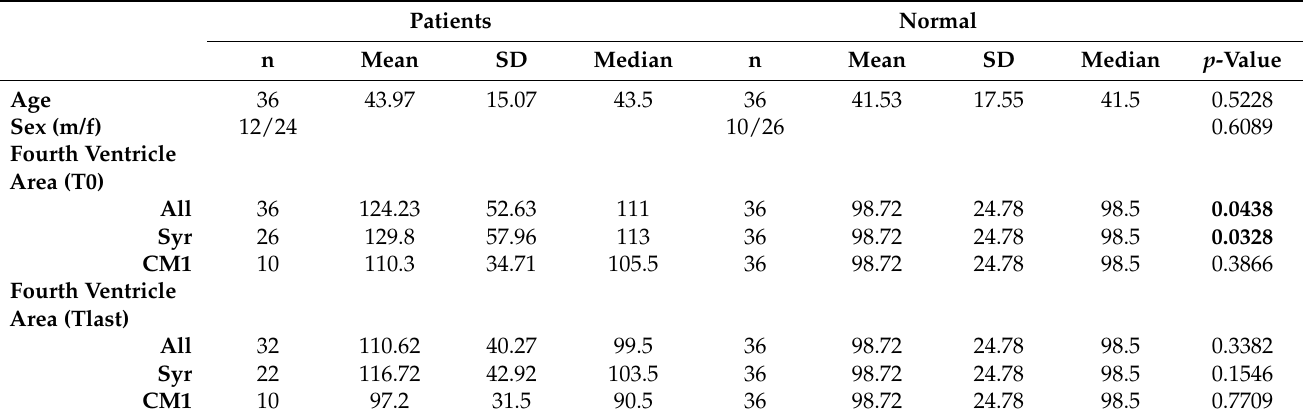
Table 4. Fourth ventricle area: patients vs. normal controls at T0 and Tlast.